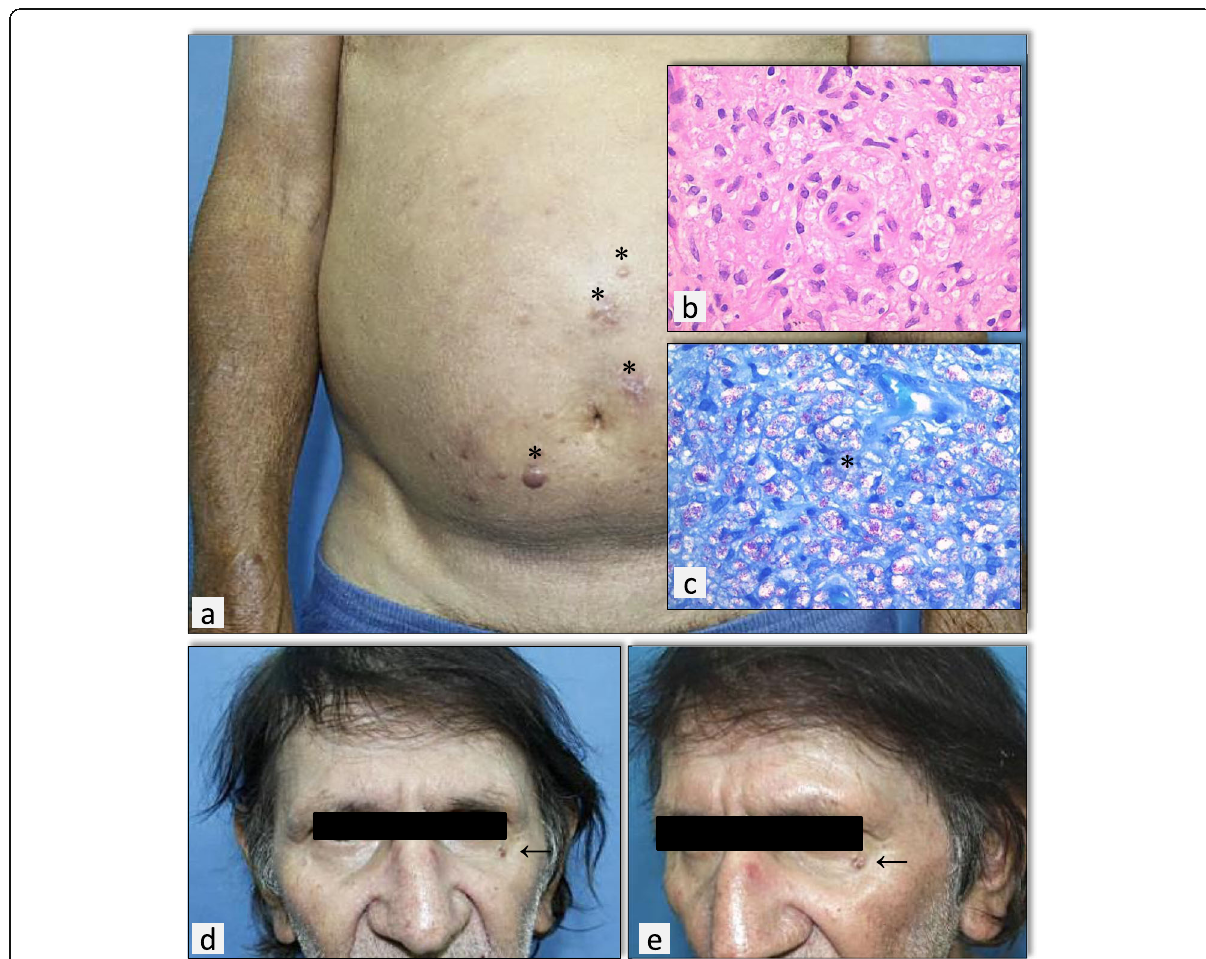
Fig. 3 Clinical characteristics of leprosy lesions and basal cell carcinoma in case 3. a Patient with leprosy in the borderline Virchowian form (BL) presenting papule-nodular lesions (hansenomas) in the abdomen (*). b Histological sections (HE) of abdominal lesion showing leprosy lesions compatible with BL and characterized by multivacuolated histiocytes. c Bacilloscopy of histological sections (FF) shows numerous bacilli in the cytoplasm of macrophages (*). d and e On the face, the patient presents madarosis associated with a pigmented lesion with features of basal cell carcinoma, located in the lower left peripalpebral region ( ←